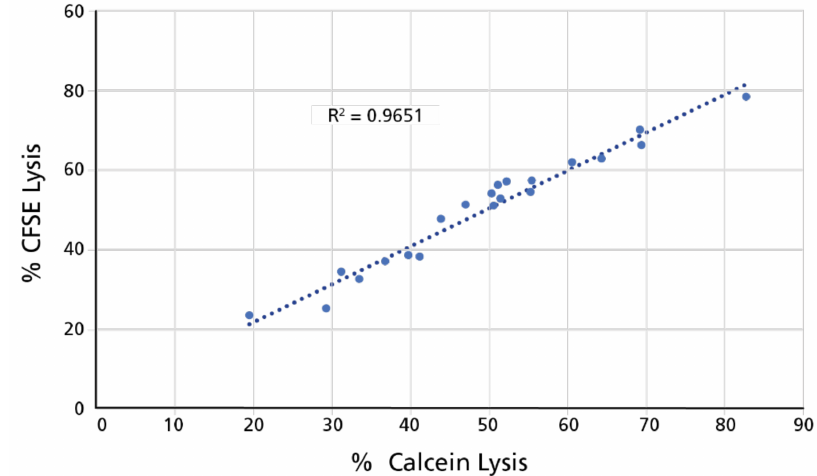
Figure 7. Results of % killing established by Calcein TVA and CFSE/PI TVA closely match. PBMC of 21 donors were tested in the two assays side by side. The results obtained for the 100:1 effector to target ratio are plotted here against each other. The correlation quotient for the closeness of fit is shown.